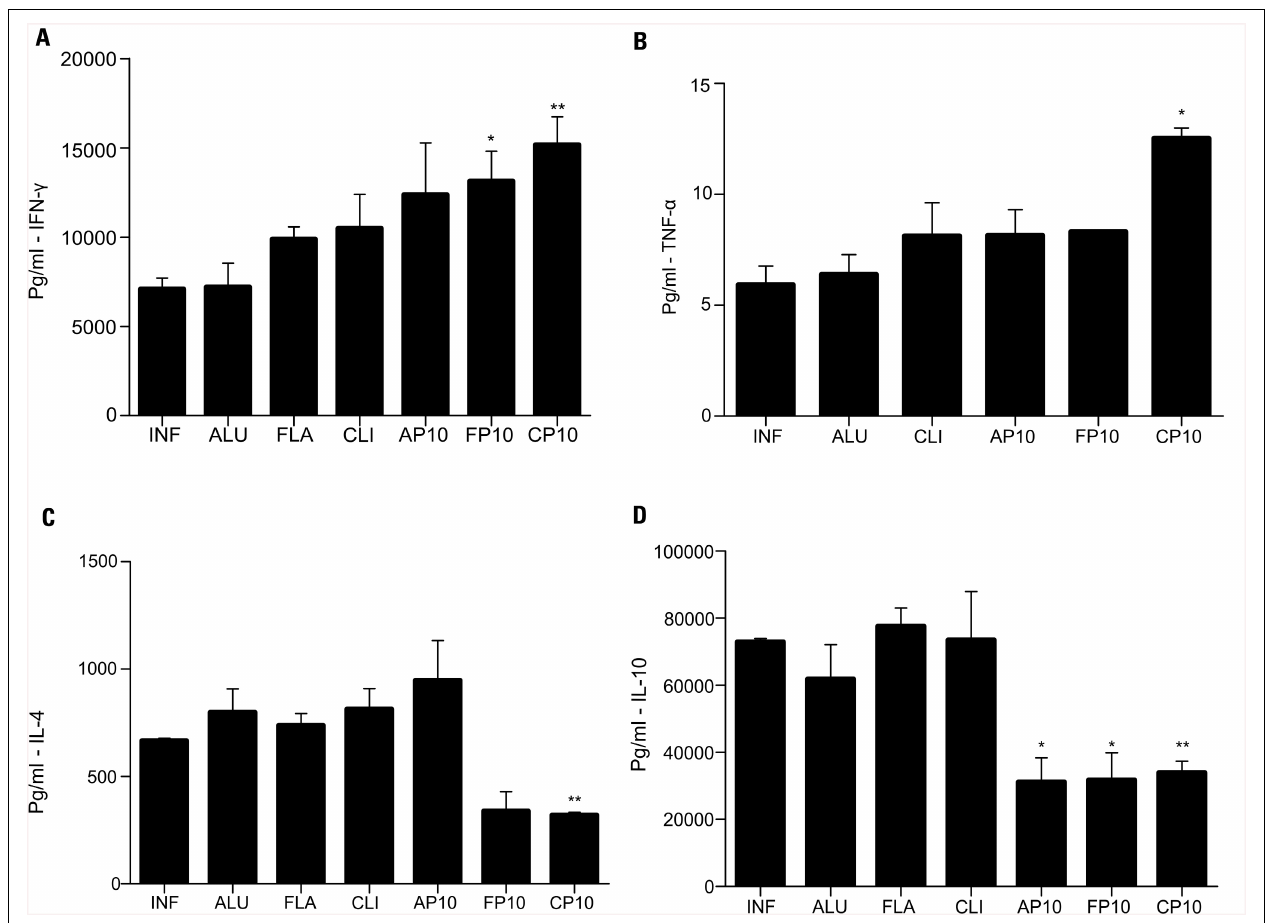
infected control mice (INF); animals infected and immunized with aluminum hydroxide alone (ALU) or with P10 (AP10), FliC flagellin alone (FLA) or with P10 (FP10), and cationic lipid alone (CLI) or with P10 (CP10). * p < 0.05: significance p < 0.05 compared to control mice (only infected). ** p < 0.01: compared to control mice (only